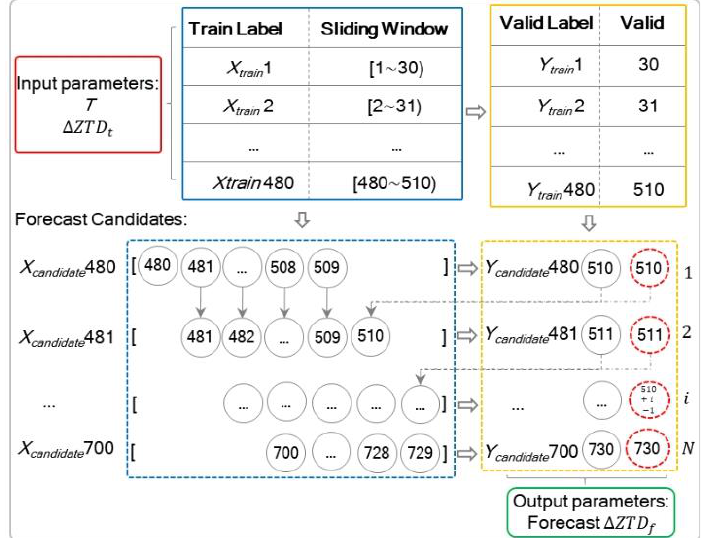
Figure 8. Network training and validation flow chart. The red box shows the input parameter, which consists of T and the ZTD differences ( ∆𝑍𝑇𝐷 𝑡 ) between the KNN and the periodic model. The blue box expresses the training sets, the orange box shows the validation sets, and the red circle represents the original differences between KNN and the periodic model. The green box shows the output forecasting results, ∆𝑍𝑇𝐷 𝑓 .